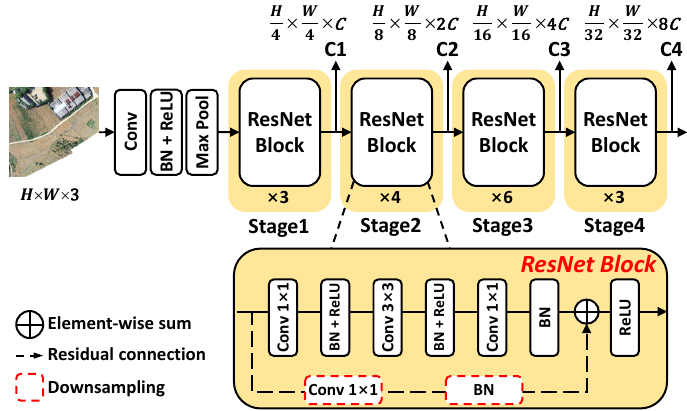
Figure 2. The architecture of